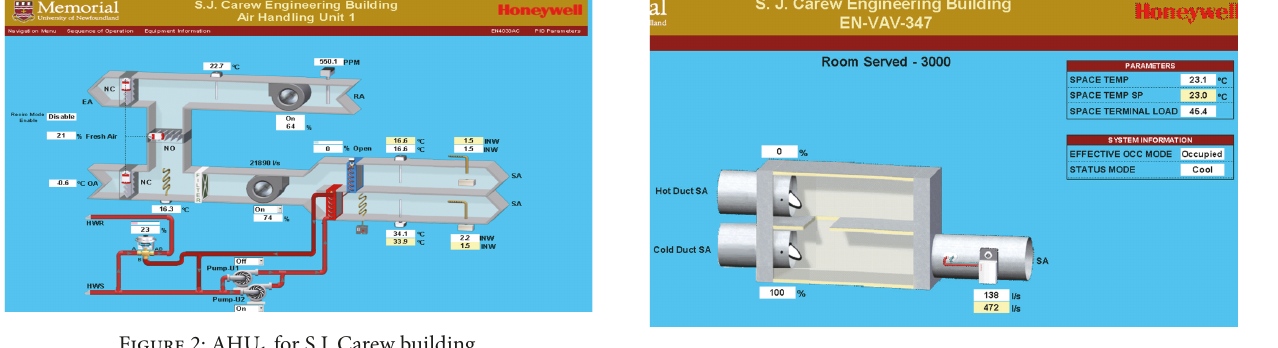
Figure 3: VAV terminal units of room 347 at the Carew